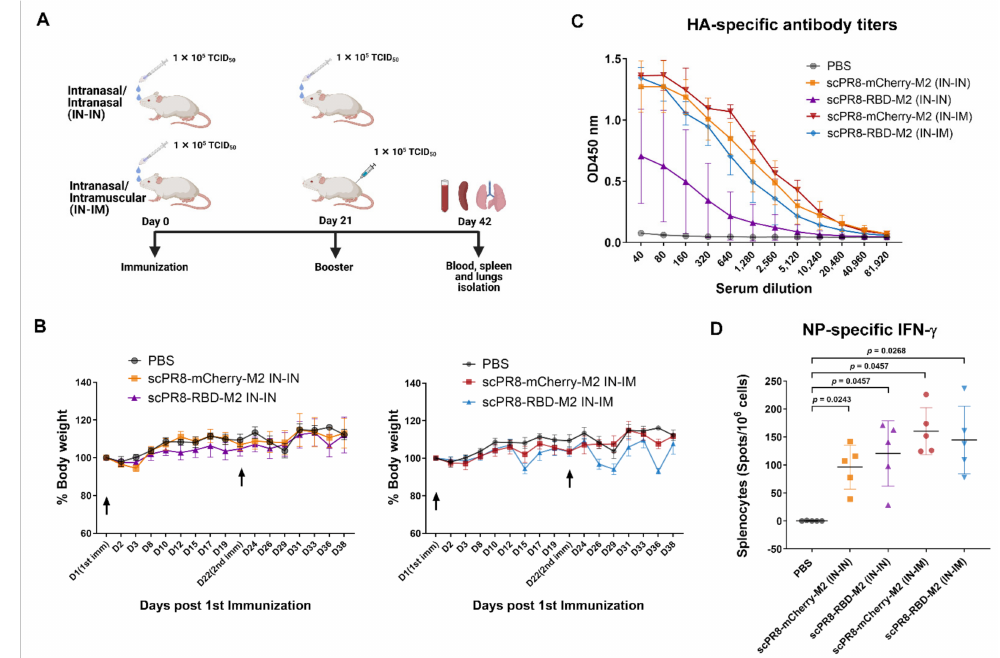
Figure 4. Immunization schedule and immune responses to influenza virus proteins. ( A ) Experimental design displaying vaccination schedule, routes, and sample collection. ( B ) Weight of individual mice was measured for the duration of study to monitor for any signs of disease. ( C ) HA specific antibody response measured by ELISA. ( D ) Splenocytes were stimulated with the conserved H2-K d -restricted NP peptide 147–158 [18]. Influenza A NP-specific T cells were quantified using ELISPOT assay. Error bars represent the mean ± standard error of mean. p values < 0.05 were considered statistically